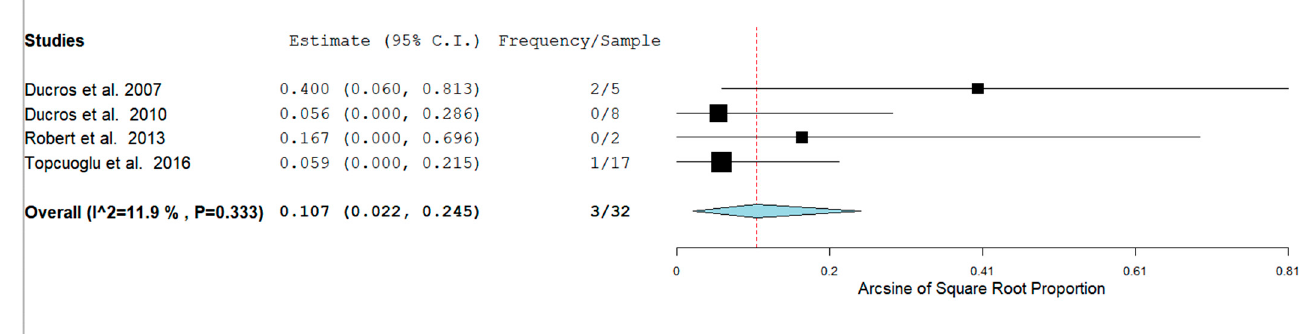
Figure 5. Rate of SAH among females with RCVS in the Postpartum Period.